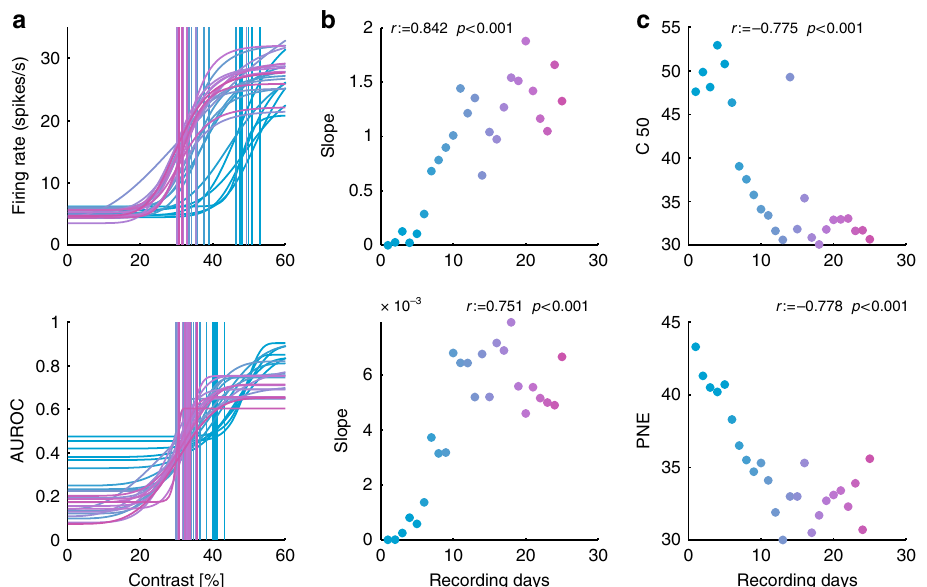
Fig. 1 Example channel. a Single-channel contrast response functions and neurometric function as a function of learning (colour coded transitions red to blue). Vertical lines show location of C 50 for each recording day. b Slope of the contrast response function and neurometric function at 30% (the sample contrast). c Change of the C 50 and the PNE with